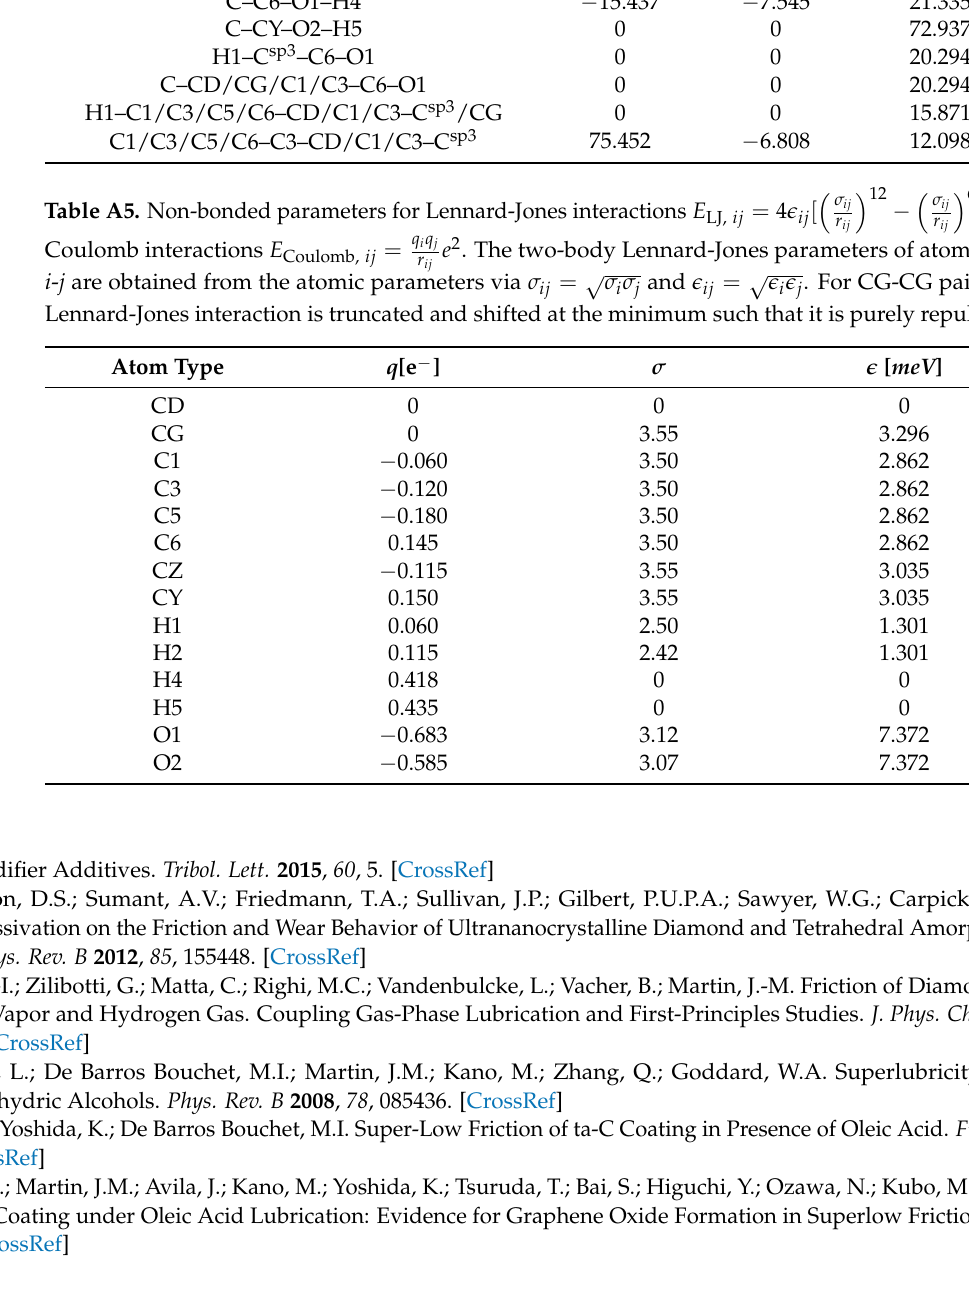
Table A4. Fourier coefficients for dihedral interactions of the form E dihedral = 1 1